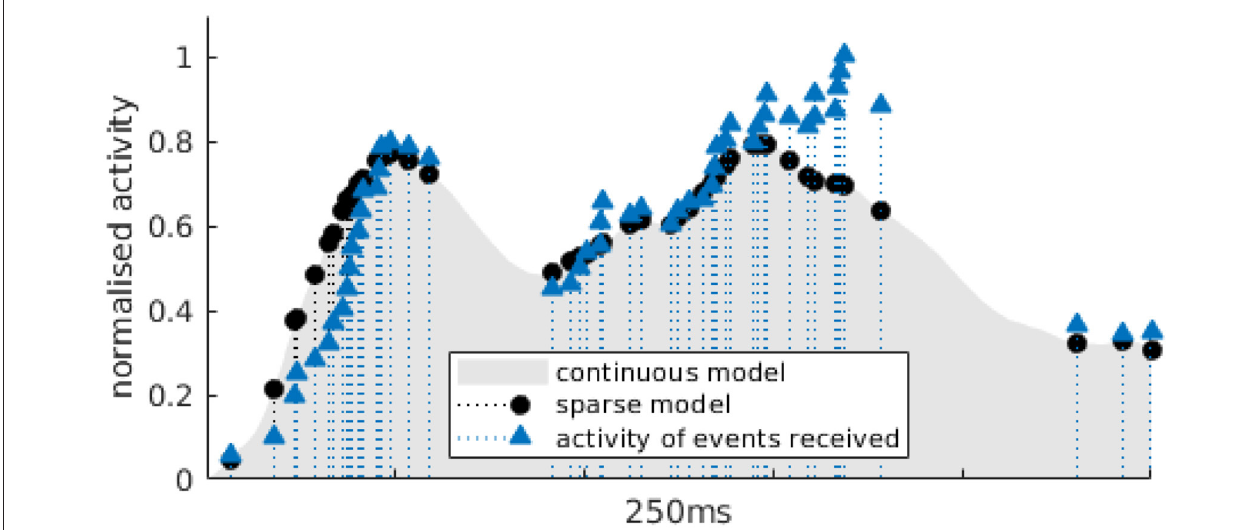
FIGURE 4 | Example of the samples used to calculate the sparse cross-correlation for the OFF activity of an actual blink. The gray area represents B OFF , the activity model for OFF events (in that particular example, it is previously built for outdoor data sets). Blue triangles correspond to the activity A ( t i ) for which events have been received in the current time window. Black dots are the B OFF ( t i ), the value of activity in the model at the same times-tamps as incoming events.